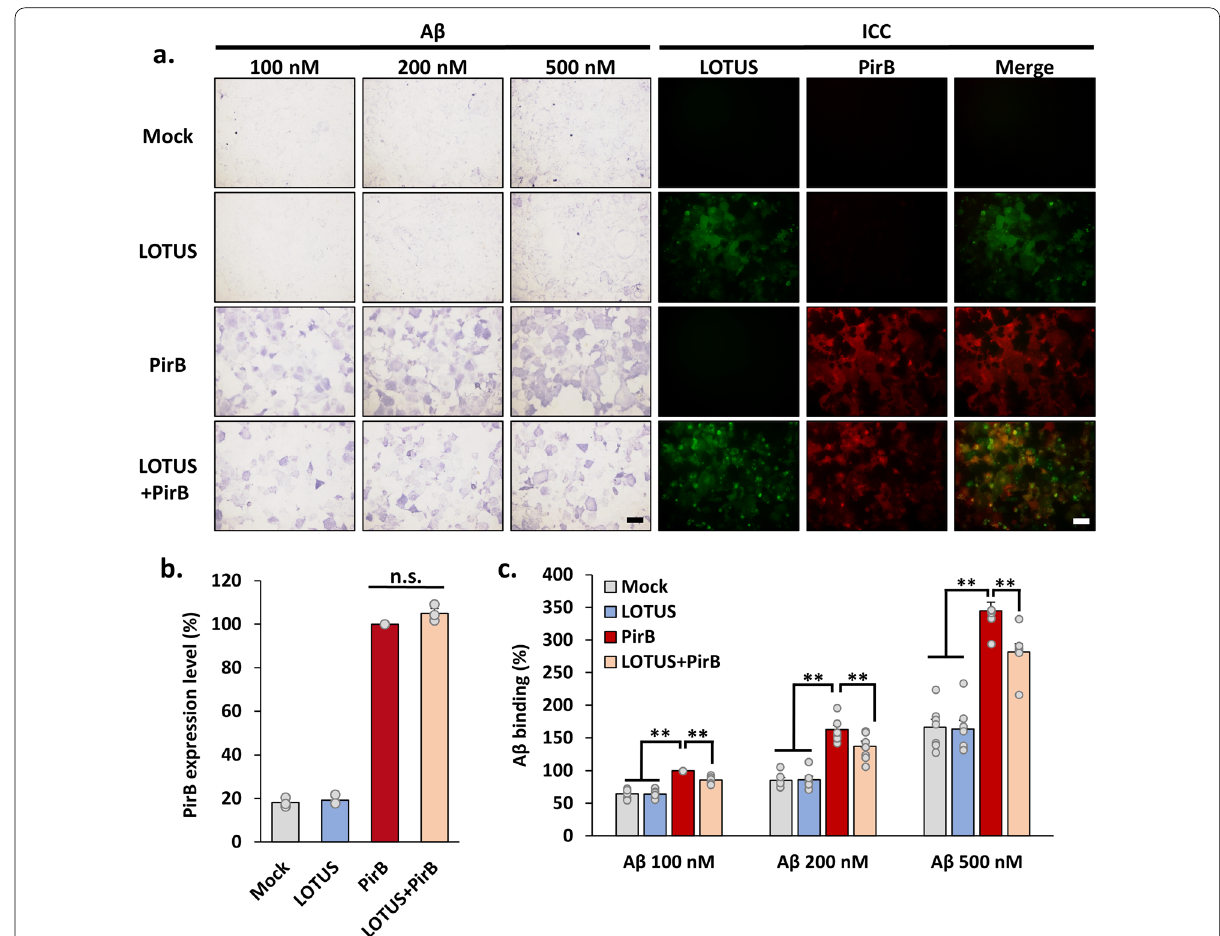
Fig. 1 LOTUS inhibits Aβ-PirB binding. a Representative images of the binding assay in Cos7 cells overexpressing LOTUS or PirB. The cells were treated with biotin-conjugated-human Aβ and immunostained using LOTUS or PirB antibody without Aβ. Scale bars, 100 µm. b Quantification of cell surface expression level of PirB in Cos7 cells overexpressing PirB and/or LOTUS. Each expression level of PirB was normalized to the expression level in Cos7 cells overexpressing PirB alone, and the data are presented as mean standard error of the mean (SEM) from four independent cell ± culture preparations (n 4, one way analysis of variance ANOVA post hoc Tukey test n.s., not significant). c Quantification of Aβ binding in Cos7 cells = overexpressing LOTUS and/or PirB. Aβ binding levels in each group. Binding levels were normalized to the binding level of Aβ (100 nM) in Cos7 cells overexpressing PirB alone. The data are presented as mean SEM (n 7, One-way ANOVA post hoc Tukey test * p < 0.05, ** p < ± =